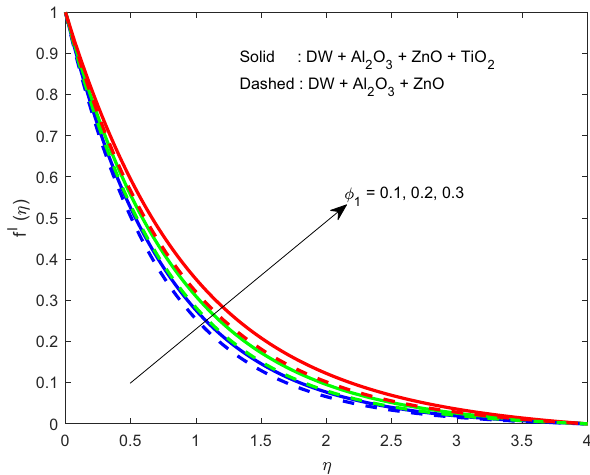
Figure 3: Increasing e ff ects of ϕ 1 on f ′ ( η )